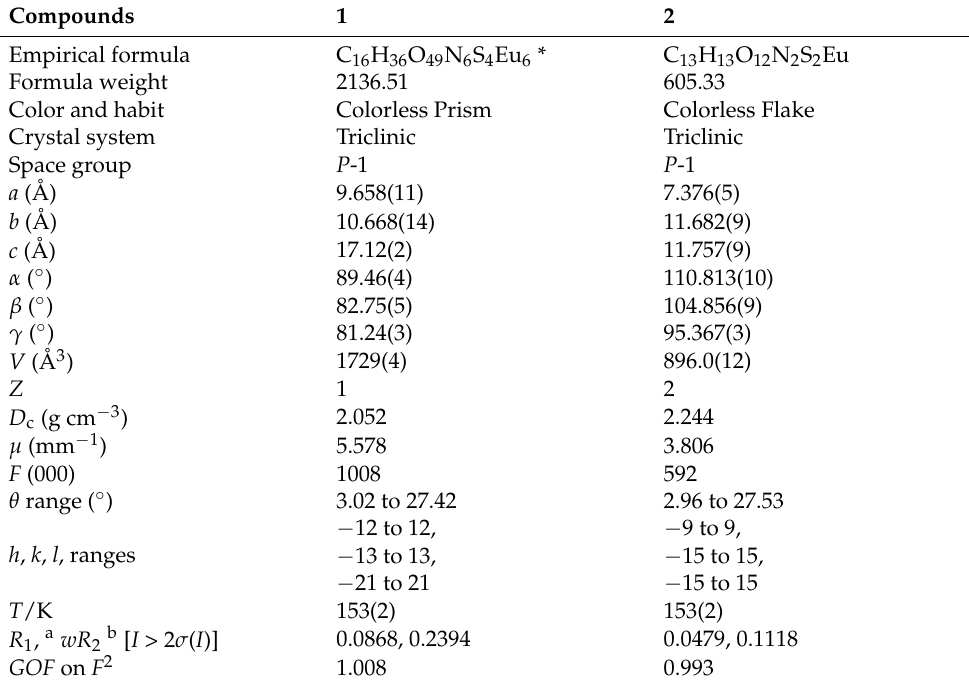
Table 1. Crystal data and structure refinement parameters for compounds 1 – 2 . Compounds 1 2 Empirical